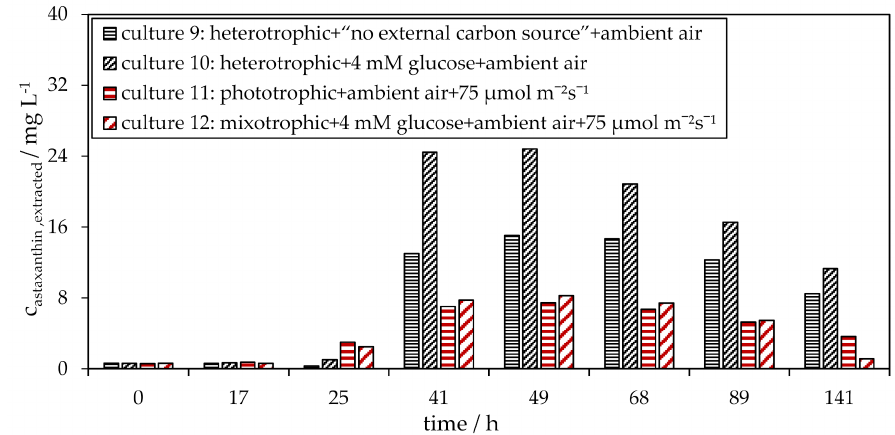
Figure 7. Astaxanthin concentration in the ethyl acetate extract of the heterotrophic culture 9 (heterotrophic + “no external carbon source” + ambient air) and culture 10 (heterotrophic + 4 mM glucose + ambient air), phototrophic culture 11 (phototrophic + ambient air + 75 µ mol m − 2 s − 1 ) and mixotrophic culture 12 (mixotrophic + 4 mM glucose + ambient air + 75 µ mol m − 2 s − 1 ) at different time points after the start of germination; data obtained by single